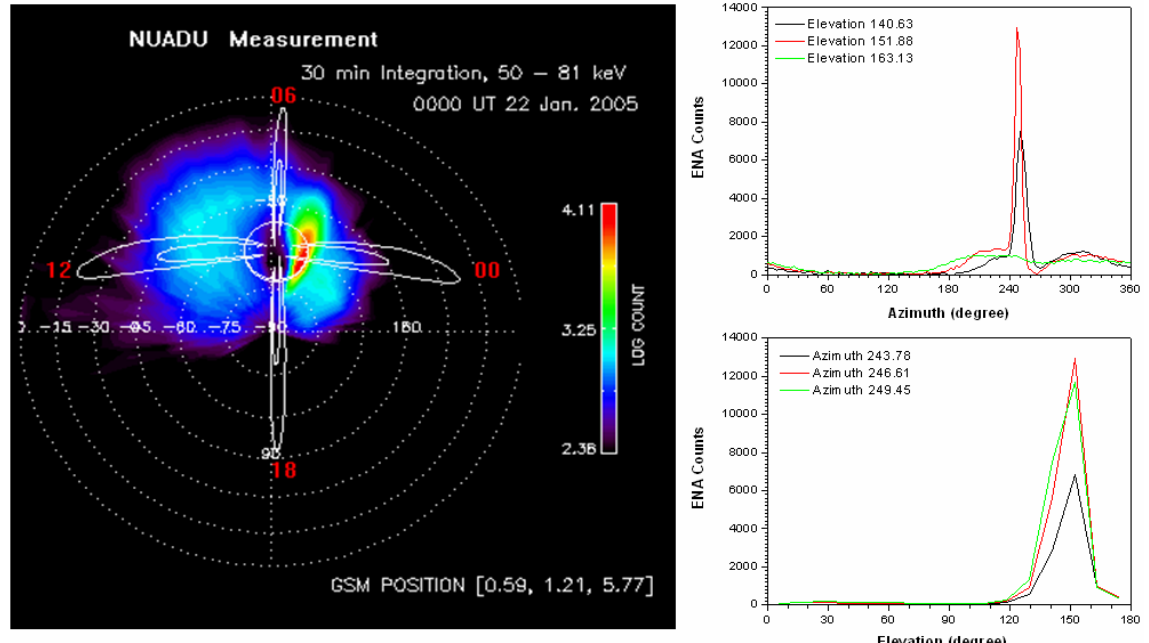
Fig. 1. ENA image (left panel) recorded by NUADU on 22 January 2005 from 00:00 to 00:30UT in energy Channel 2. The elevation scale is indicated by closed dashed white rings and the azimuth scale by (labeled) dashed lines. The color scale indicates the logarithm of particle counts. Solid white curves represent constant L-values ( L =4, 8). Four local times are shown in red. ENA-count distributions are plotted to the right vs. azimuth (top) and elevation (bottom), where red curves relate to the ENA intensity maximum, and black and green curves relate to locations closely surrounding the location of ENA maximum.